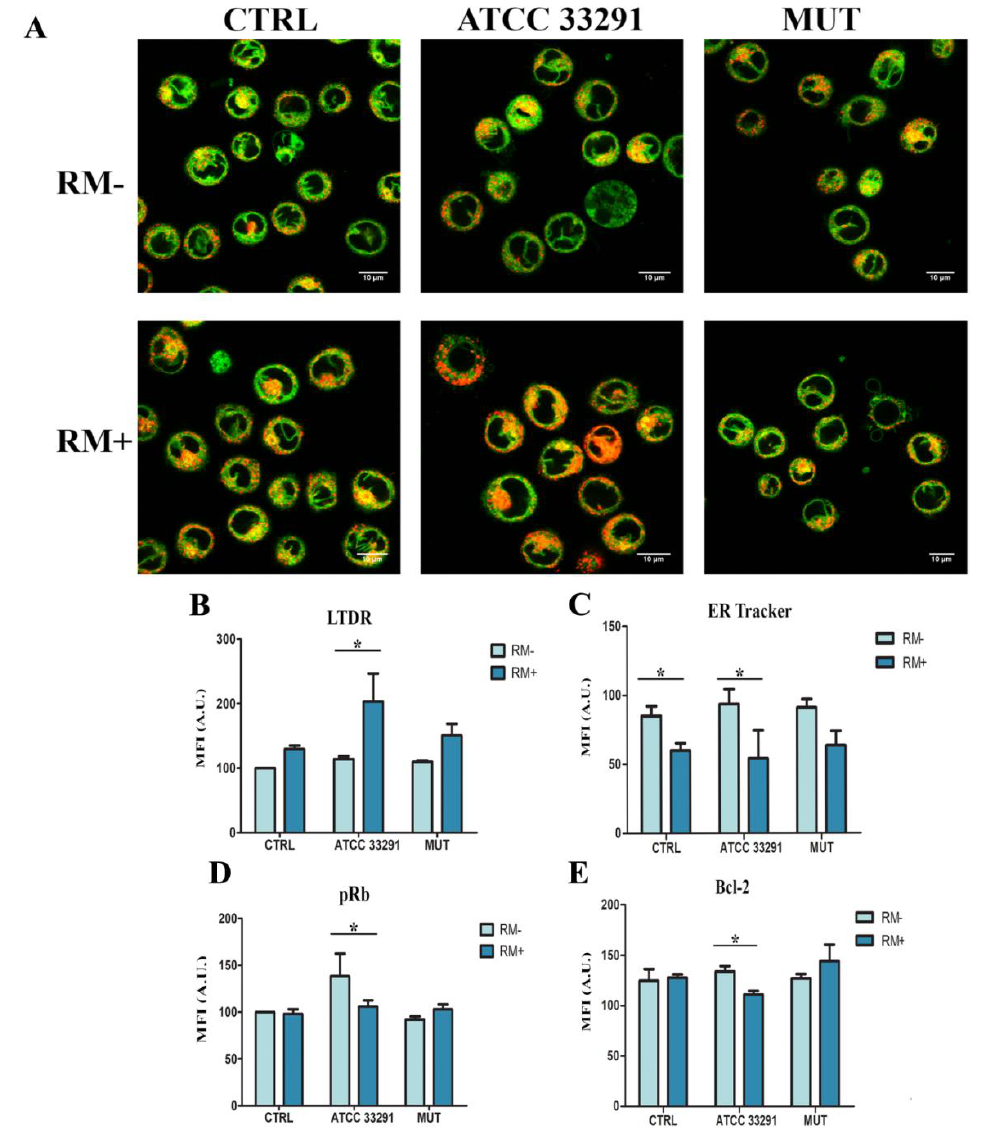
Figure 4. Concomitant evaluation of ER tracker and LysoTracker Deep Red (LTDR) fluorescence by qualitative analysis (confo) ( A ) Single confocal optical sections of ER Tracker (in green) and LTDR (in red) of untreated U937 cells (CTRL) and U937 cells preincubated with lysates after 72 h of treatment with and without RM. Where present, co-localization is shown in yellow-orange. Lower pictures show U937 cells pre-treated with RM for 2 h before lysate administration. Bars: 10 µ M. Contemporaneous evaluation of ER tracker and LTDR fluorescence by quantitative analysis (flow cytometry). ( B,C ) For investigated parameters, ER (by ER Tracker staining) and lysosomes (by LTDR staining), a comparison between RM- and RM + values was carried out for each experimental condition at 72 h. The pRb and bcl-2 expression modulated by lysates (light blue) and lysates + RM (dark blue). ( D ) Statistical histograms of MFI of pRb were calculated after 72 h from lysate administration in distended cells with and without RM. Each value was converted to arbitrary units (A.U.), setting the control as 100. ( E ) Statistical histograms of MFI of bcl-2 was calculated after 72 h from lysate administration in distended cells with and without RM. Each value is expressed as a mean ± SD (results from n ≥ 3 independent experiments). Asterisks denote a statistically significant di ff erence (* = p < 0.05) between